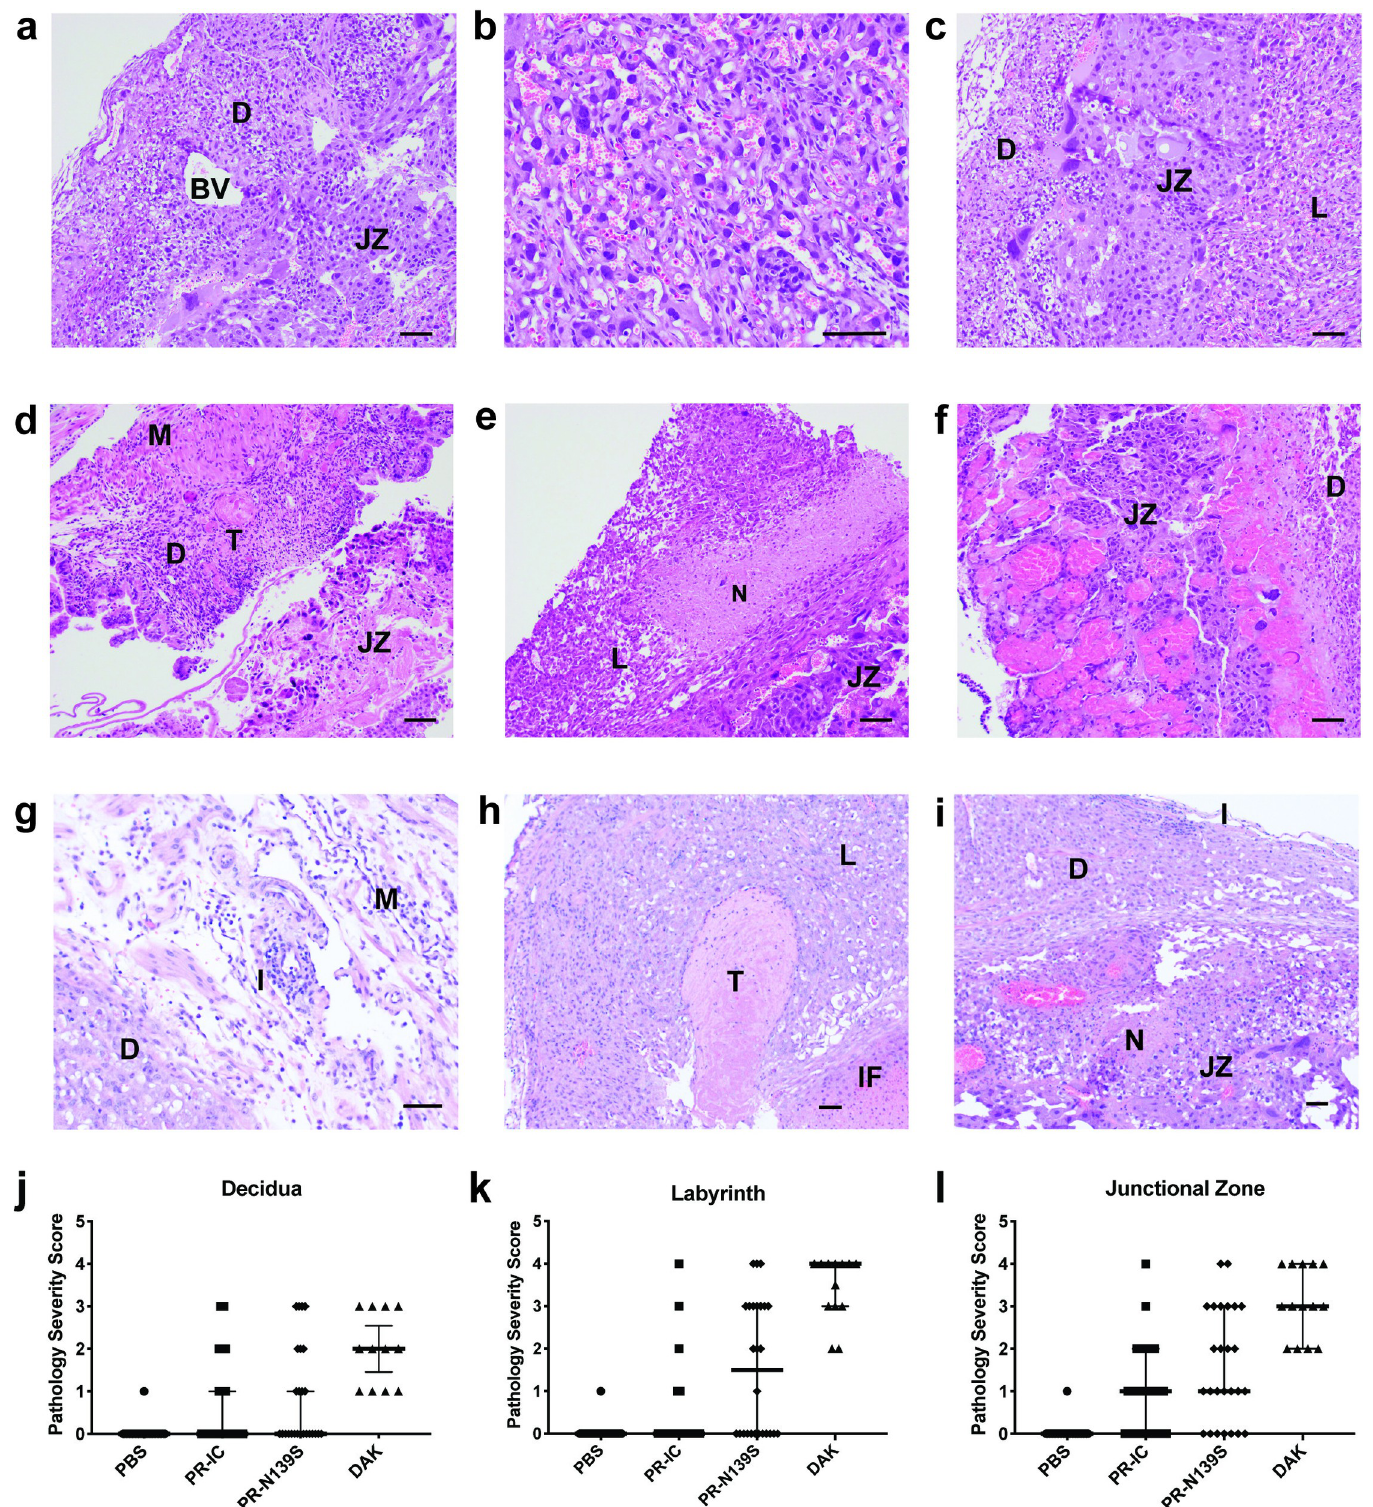
Fig 3. Placenta histopathology analysis: Hematoxylin and eosin (H&E) staining of placenta and fetus. (a-c) Normal histologic features of each placental zone (decidual layer (D), labyrinth layer (L), and junctional zone (JZ)) from concepti from dams inoculated with PBS. BV, normal decidual blood vessels. (d-f) Severe